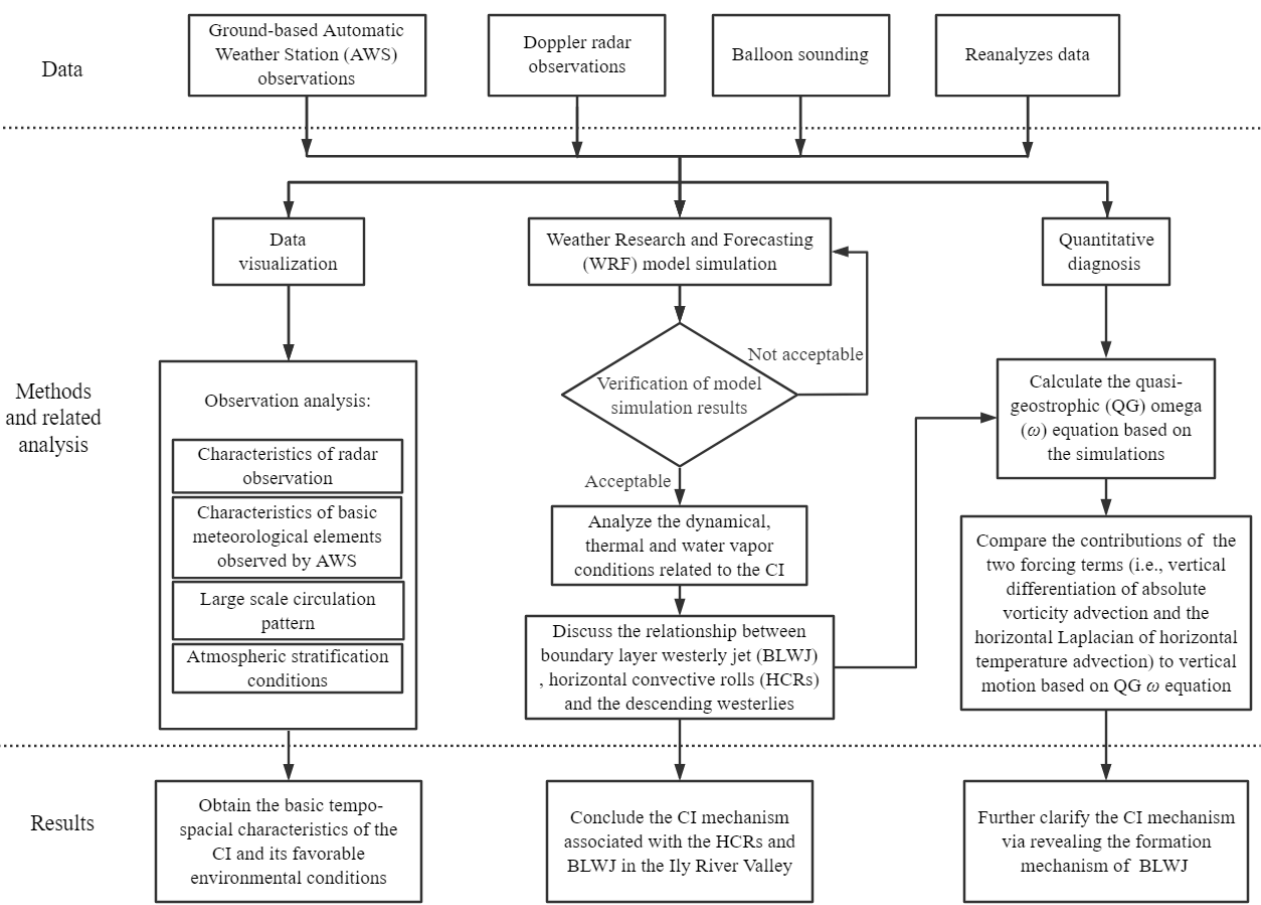
Figure 2. Flowchart of the methodology used in this study. The CI is often defined as the first echo of ≥ 35 dBZ within a convective cloud [7,37–40], which is also adopted in this paper. As shown in Figure 3a, there was a CI (denoted as black ellipse and labeled as CI1) occurred at about 90 km northwest of Yining radar station at 1024 UTC. By 1035 UTC (Figure 3b), several other CIs (labelled as CI2–CI7) occurred succes- sively to the northwest and southeast of the CI1. In the following ~1 h (Figure 3c,d), most of the CIs underwent obvious development and merged into relatively large and intense MCS during their continuous eastward movement. The strongest composite reflectivity of the MCS exceeded 60 dBZ (Figure 3d). At 1158 UTC (Figure 3e), the MCS evolved into a more intense and organized form that roughly oriented in north-south direction near the Yining radar station. Furthermore, it is interesting to note that the convection in the MCS showed a quasi-linear arrangement oriented in northeast-southwest direction (indicated by black arrows in Figure 3e) with almost equal spacing. The quasi-linear convective system were most significant in the central part of the MCS, and showed roughly parallel distribution. However, its northern and southern parts were dominated by isolated convective cells (or clusters). The roughly parallel distribution patterns of the convective lines were similar to the morphology of the horizontal convective rolls (HCR) to some extent. By 1214 UTC (Fig- ure 3f), the MCS got further development, and became a north-south oriented linear MCS (i.e., squall line) that was about 80 km in length and 20 km in width. The MCS generated heavy precipitation in many places in the study area during its eastward